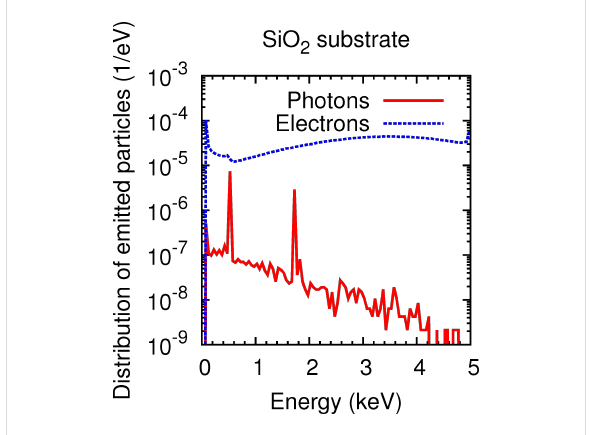
Figure 6: Distribution of electrons backscattered and emitted into the vacuum from the substrate in the absence of a deposit (dashed curve) and distribution of photons emitted into the vacuum (solid curve). Note, that the ordinates are in a logarithmic scale, whereas the abscissas are in a linear